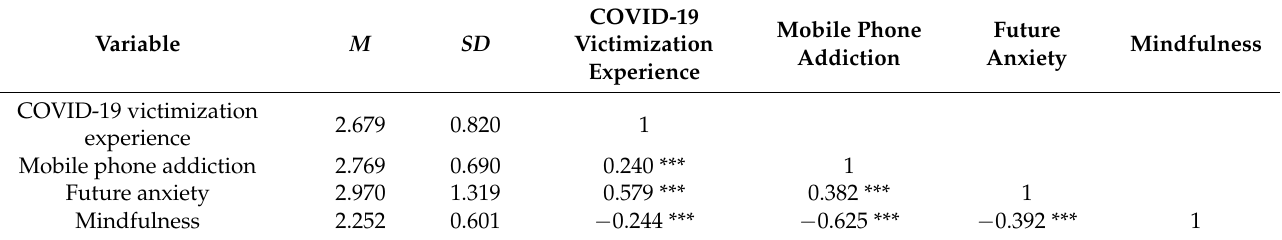
Table 6. Descriptive statistics and correlation